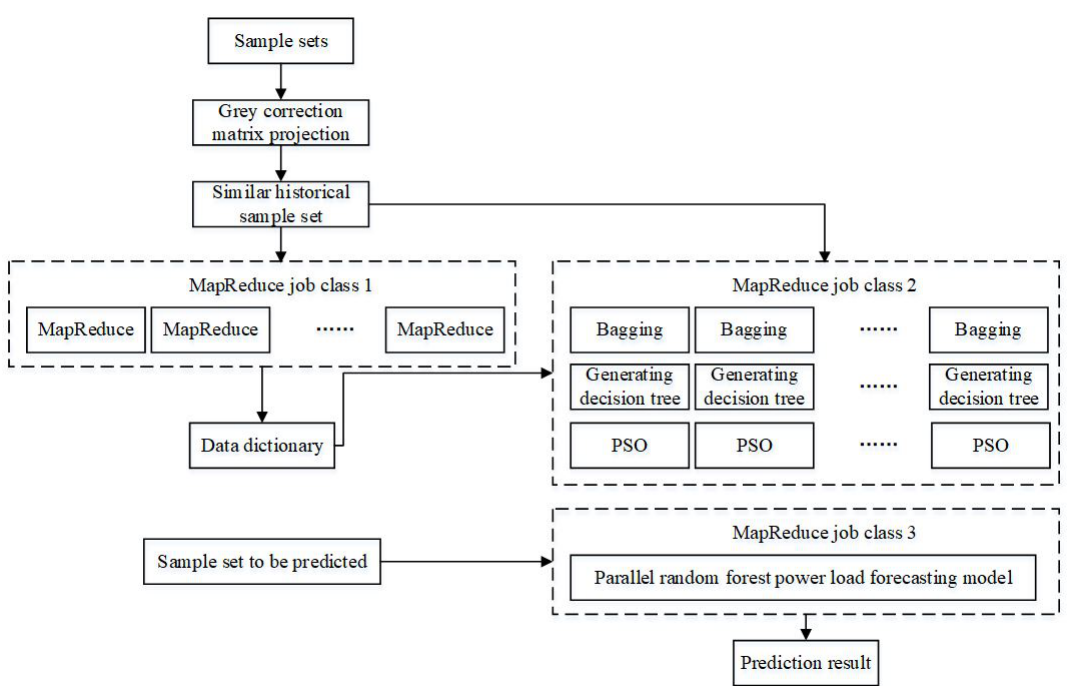
Fig. 2. Parallel random forest power load forecasting